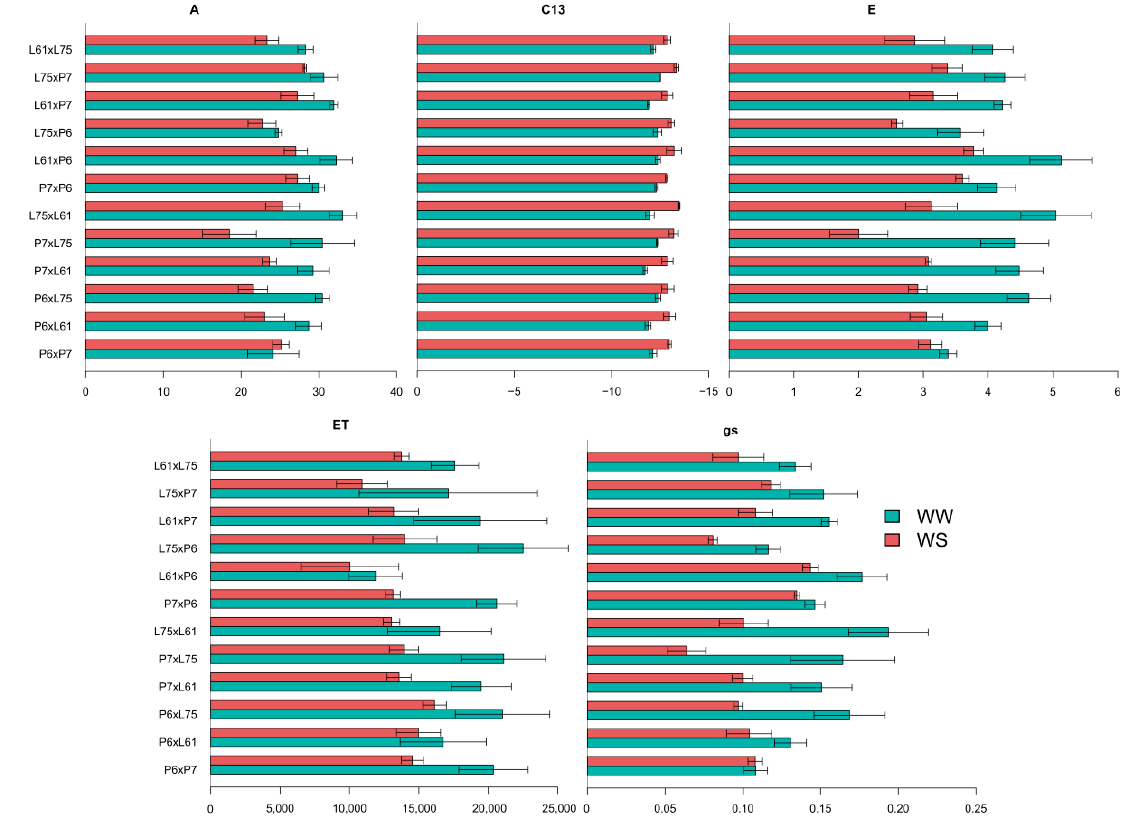
Figure 6. Estimates of the means of the water status of popcorn hybrids evaluated under water stress (WS) and well-watered (WW) conditions. WS: water stress; WW: well-watered; δ 13 C: carbon isotope discrimination; A: net CO 2 assimilation rate ( µ mol CO 2 m − 2 s − 1 ); gs: stomatal conductance (mol H 2 O m − 2 s − 1 ); E: transpiration (mmol H 2 O m − 2 s − 1 ); ET: cumulative plant transpiration (dm 3 plant − 1